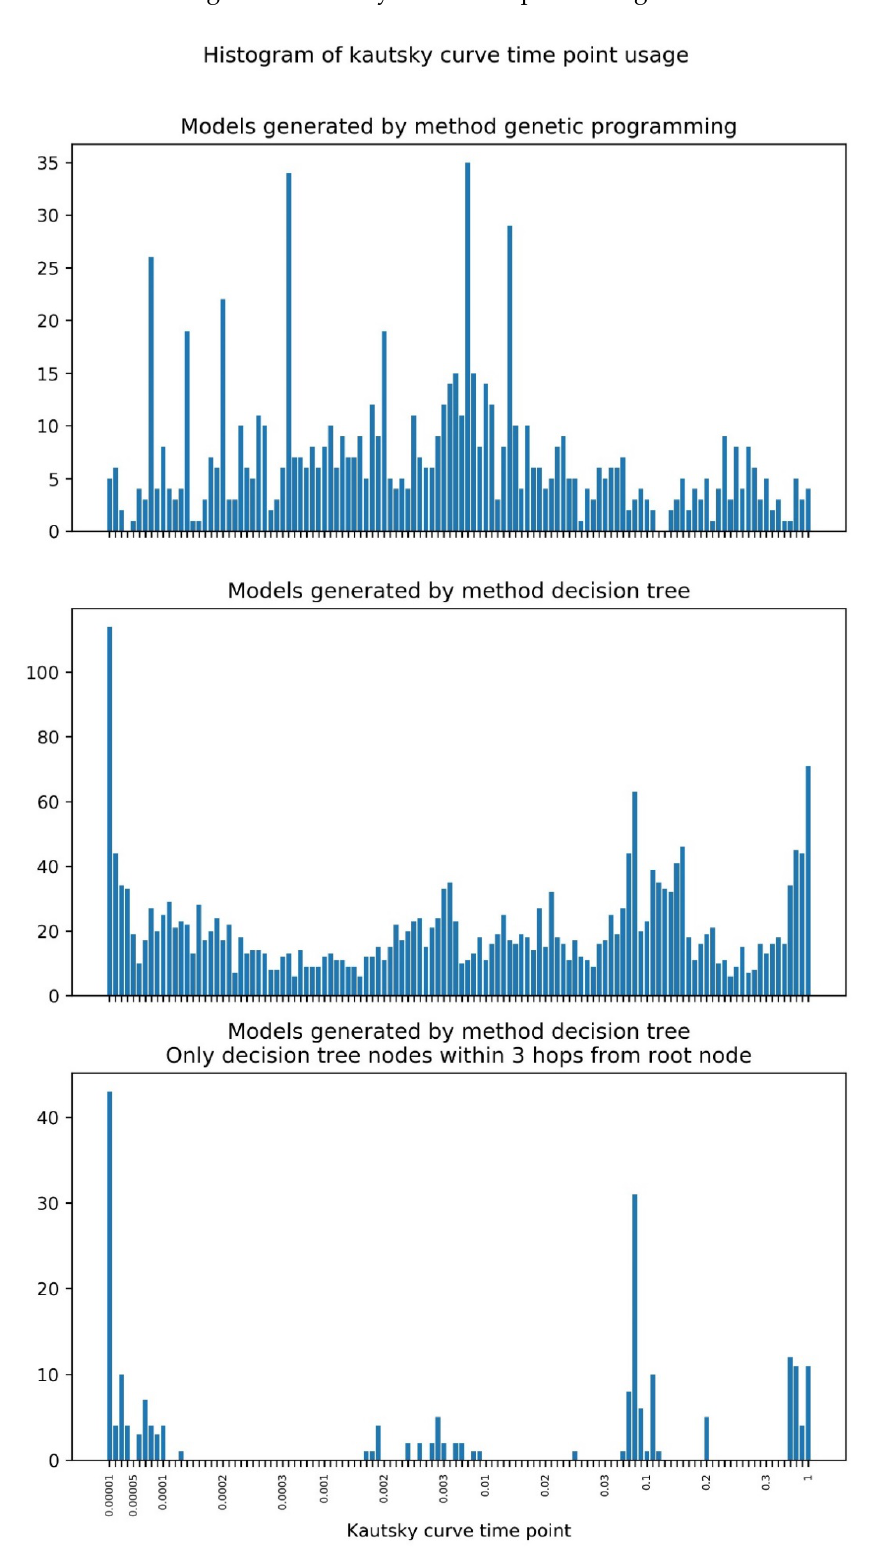
Figure 8. Histogram of Kautsky curve time point usage in the DT and GP models obtained.